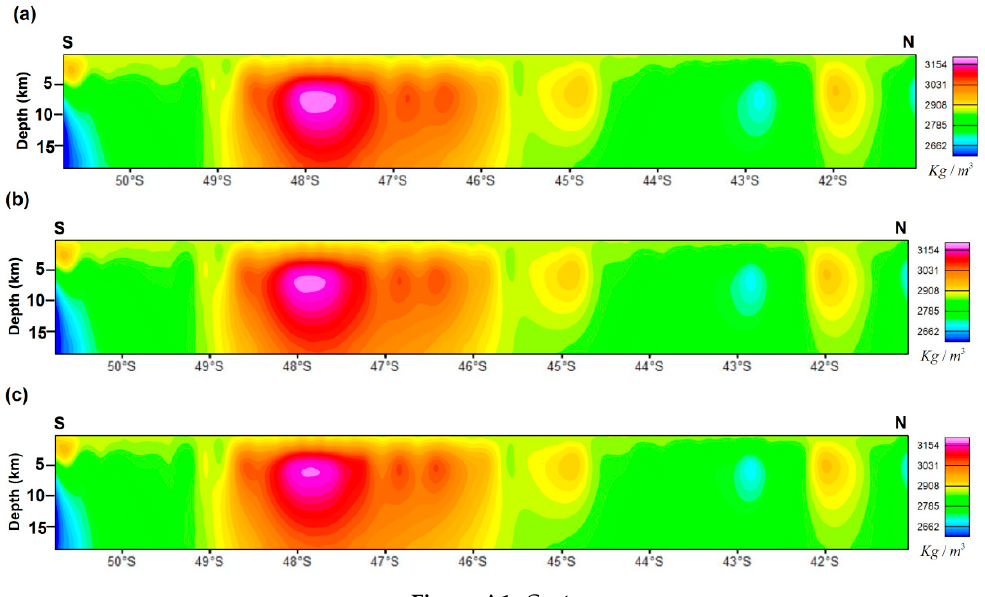
Figure A1. Some of the models that were recovered from changing the exponent of the Tikhonov parameter during 3D inversion for ( a ) 0.2, ( b ) 0.3, ( c ) 0.4, ( d ) 0.5, ( e ) 1 and ( f ) 1.5. ( a ) ( b )